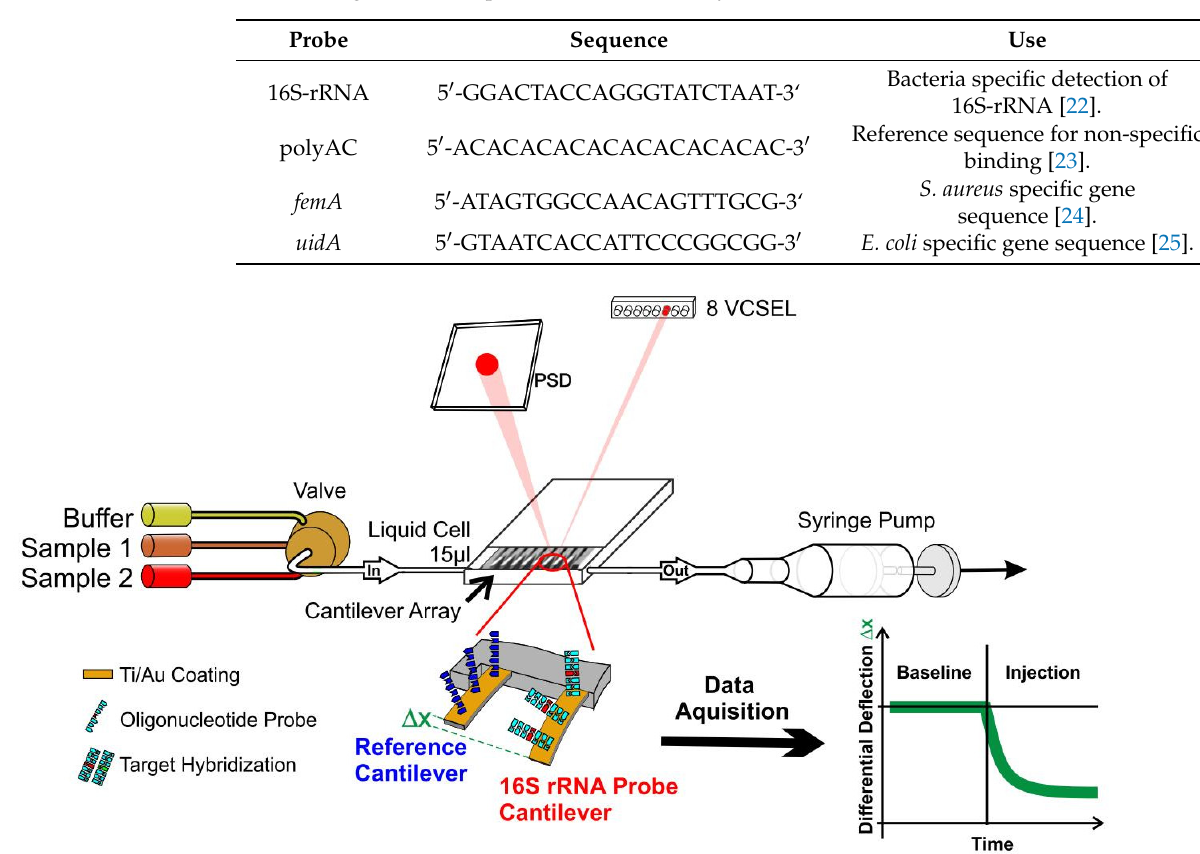
Figure 1. Schematic of a nanosensor measurement. An array of eight gold coated identical silicon cantilevers with 250 µm pitch, a length of 500 µm and a thickness of 600 nm is functionalized with a reference and a 16S-rRNA probe for detection of bacteria. The array is then mounted in a micro- fluidic cell and exposed to total RNA extracted from a patients’ blood. Bending of probe cantilevers due to hybridization is measured via multiplexed optical beam deflection readout with an accuracy of 0.1 nm. See supplementary material for further pictures and a video.